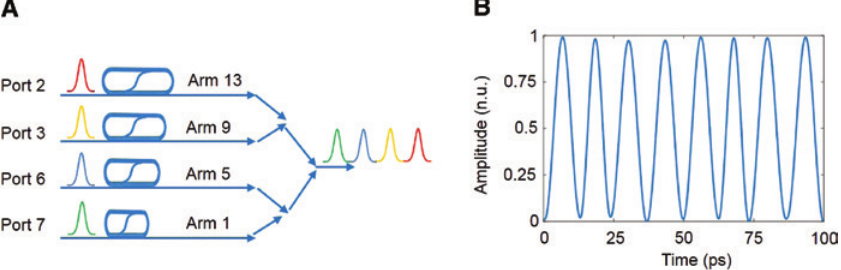
Figure 11: (A) Principle of multi-path combiner (optical time division multiplexing) realization. (B) OTDM signal realized by inputting a 1.2-ps pulse trains into four ports of the